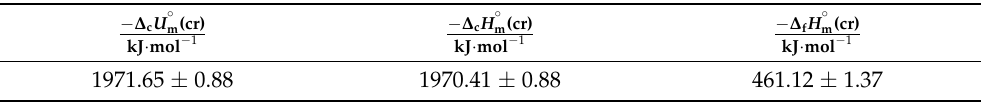
Table 4. Standard molar properties of the 1-methylhydantoin, obtained from combustion calorimetry experiments, at p ◦ = 0.1 MPa and T = 298.15